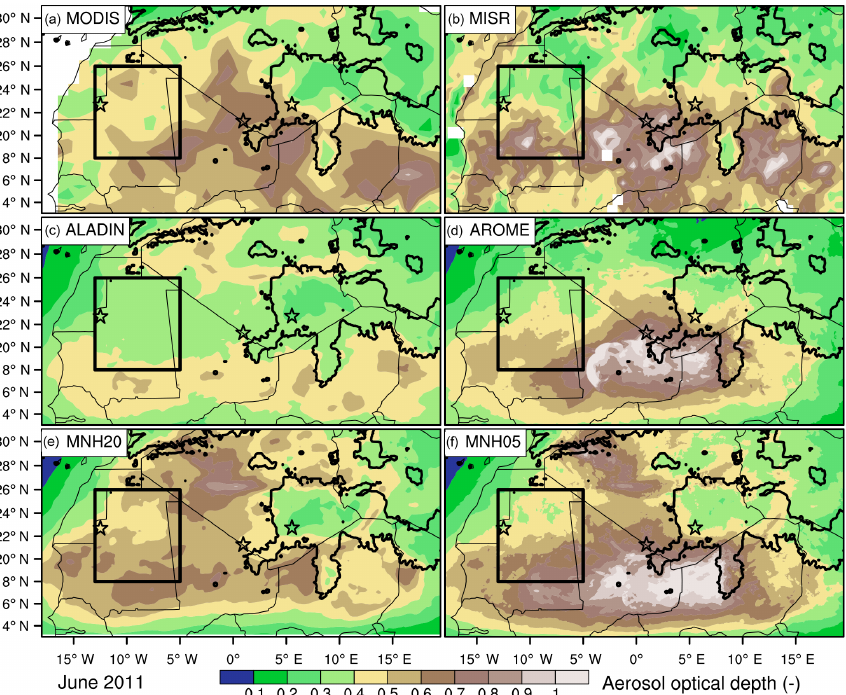
Figure 2. Aerosol optical depth around 12:00UTC in June 2011 from (a) MODIS, (b) MISR, (c) ALADIN, (d) AROME, (e) MNH20 and (f) MNH05. The solid line shows the 600m altitude. The black rectangle shows the domain of analysis. The locations of the three AERONET stations used in this study are shown with